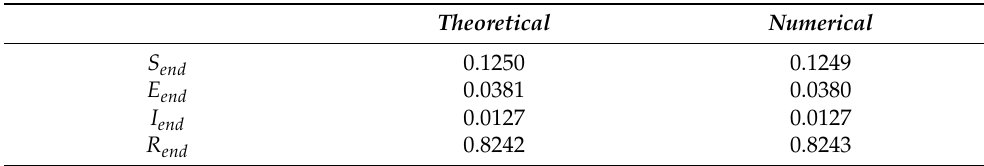
Table 1. Comparison of the theoretical values predicted by Proposition 2 and the numerically obtained ones for the location of the endemic point.